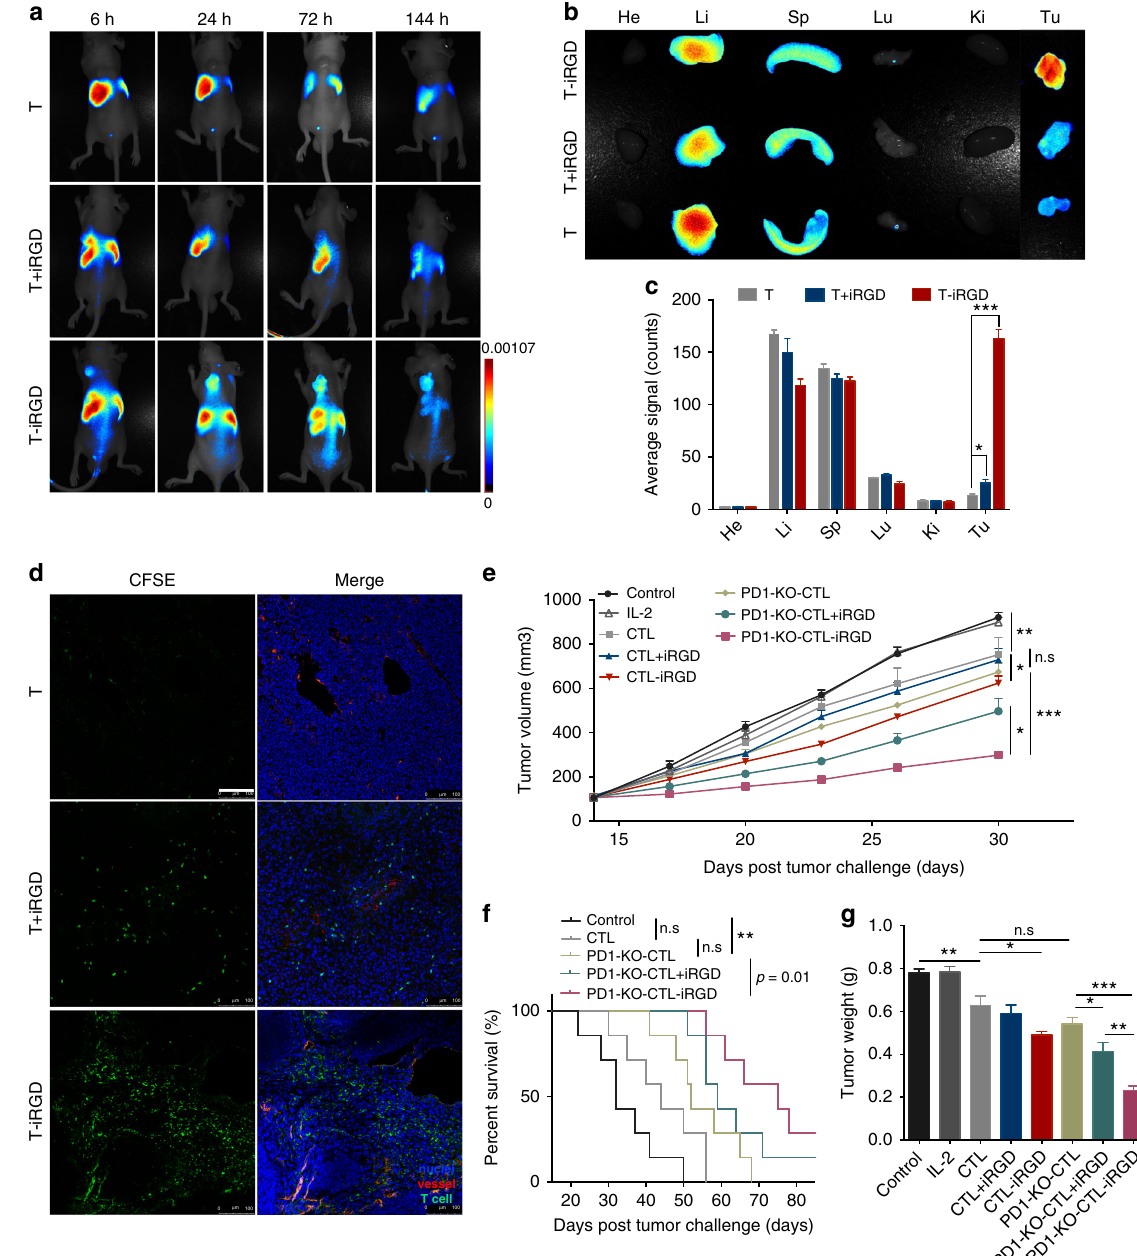
Fig. 3 iRGD modi fi cation enhanced lymphocytes in fi ltration into tumor parenchyma in a systematic administration route and overcame resistance to PD-1 disruption immunotherapy. a In vivo imaging of HGC27 tumor-bearing mice at 6, 24, 72, and 144 h after intravenous injection of DiR-labeled T cells. White dashed lines, subcutaneous tumors. b Ex vivo imaging of tumors and other organs at 144 h after T cells transfusion. c Semiquanti fi cation of T cells biodistribution in mice organs collected at 144 h post-injection. Results are expressed as mean fl uorescence intensity ± s.e.m.; n = 5. Student ’ s t test. ** p < 0.01, *** p < 0.001. d Confocal imaging of frozen tumor sections at 24 h post T cells transfusion. T cells were labeled with CFSE before intravenous injection; tumor blood vessels were labeled with anti-CD31. T cells, green; vessel, red; nucleus, blue. Scale bar, 100 μ m. e – g Enhanced antitumor effect of iRGD- modi fi ed PD-1 -disrupted CTLs in a xenograft SNU719 mouse gastric tumor model. Tumor-bearing mice received different forms of treatment every 4 days for 3 times. Tumor growth pro fi les ( e ) and survival curve ( f ) of mice treated with PBS, IL-2, CTL, CTL + iRGD, CTL-iRGD, PD-KO-CTL, PD1-KO-CTL + iRGD, and PD1-KO-CTL-iRGD. Weight of tumors collected 2 weeks post treatment ( g ). Survival curves were analyzed with log-rank test. Tumor volume and tumor weight were analyzed with Student ’ s t test. Data are represented as mean ± s.e.m., n = 7; n.s, not signi fi cant; * p < 0.05; ** p < 0.01; *** p < 0.001